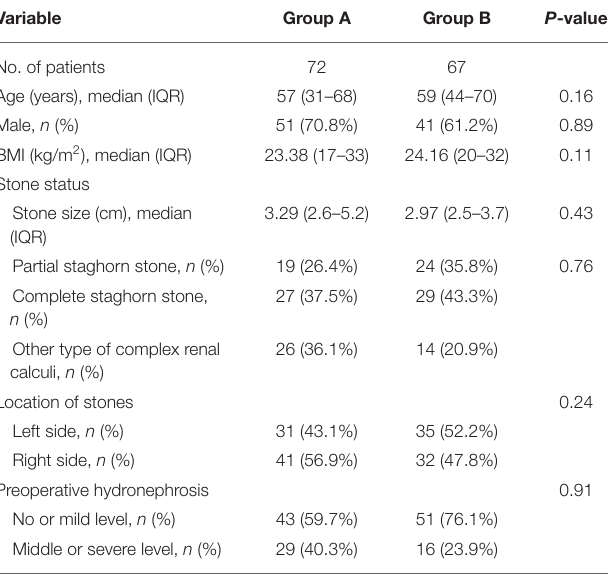
TABLE 1 | Demographic information of the patients.